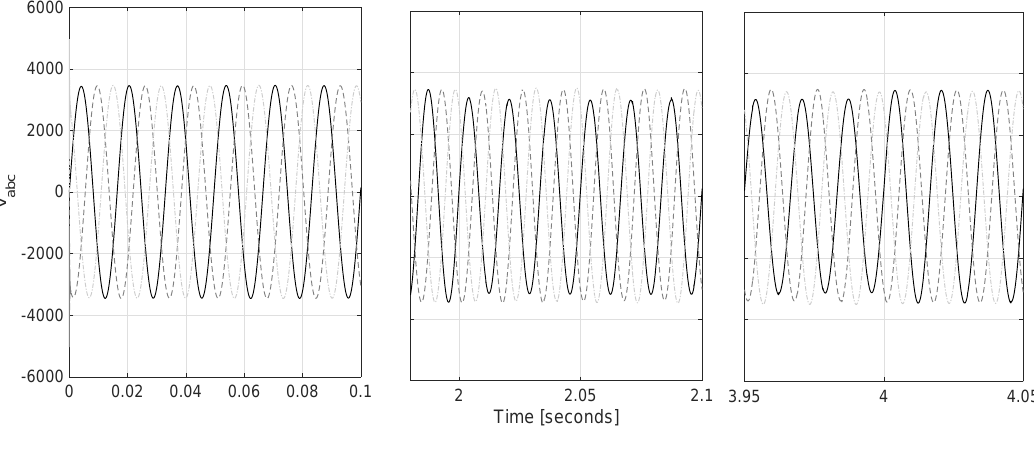
Figure 12. Simulation of voltages v abc during Test 1, with PI and AHN controls.